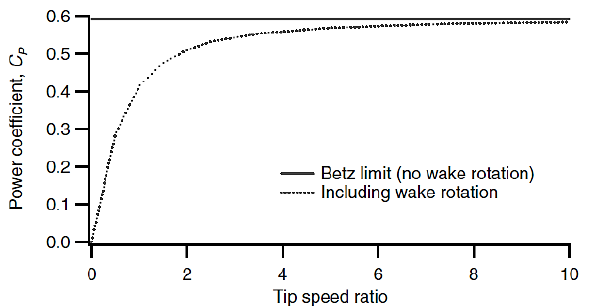
Figure 4. Theoretical maximum power coefficient as a function of tip speed ratio for an ideal horizontal axis wind turbine, with and without wake rotation .